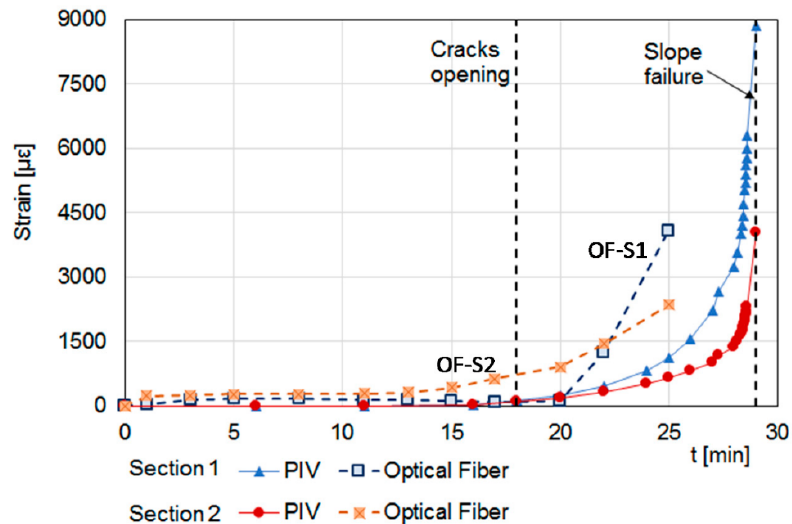
Figure 9. Distributed strain profiles measured by the transverse optical fiber strands and calculated using the digital camera at position of OF-S1 (45 cm away from the downslope) and OF-S2 (30 cm away from the upslope) (from Ref. [65]).